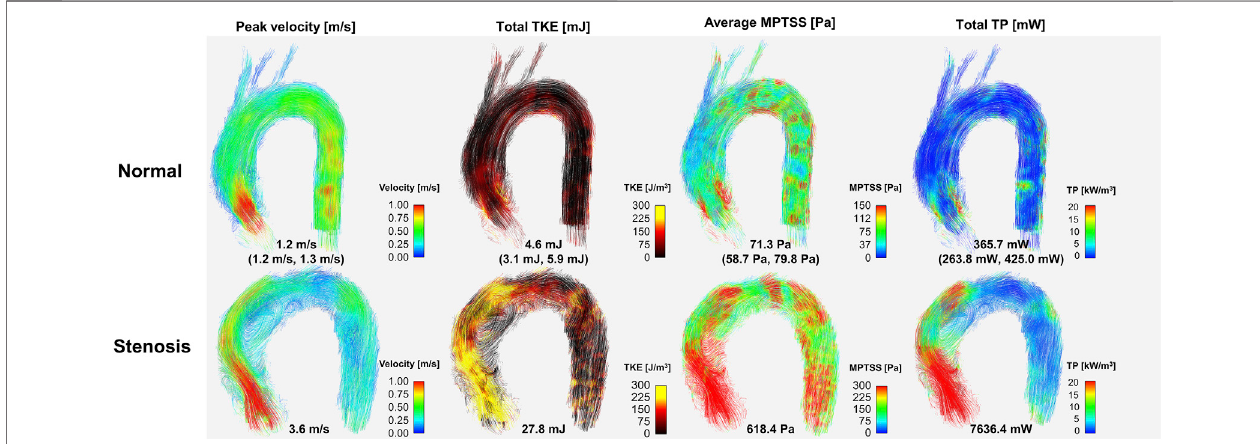
FIGURE7| Comparison hemodynamics innormalsubjectsandpatientwithsevereaorticstenosis. Notethatrepresentative normalsubject(case#1)wasused for colormapping.Valuesforthenormalsubjectaremedian(1stquartile,3rdquartile) ofthedata.Velocity,TKE,MPTSSandTPforallnormalsubjectsarealsoshown inthe Supplementary Figures S2 – S5